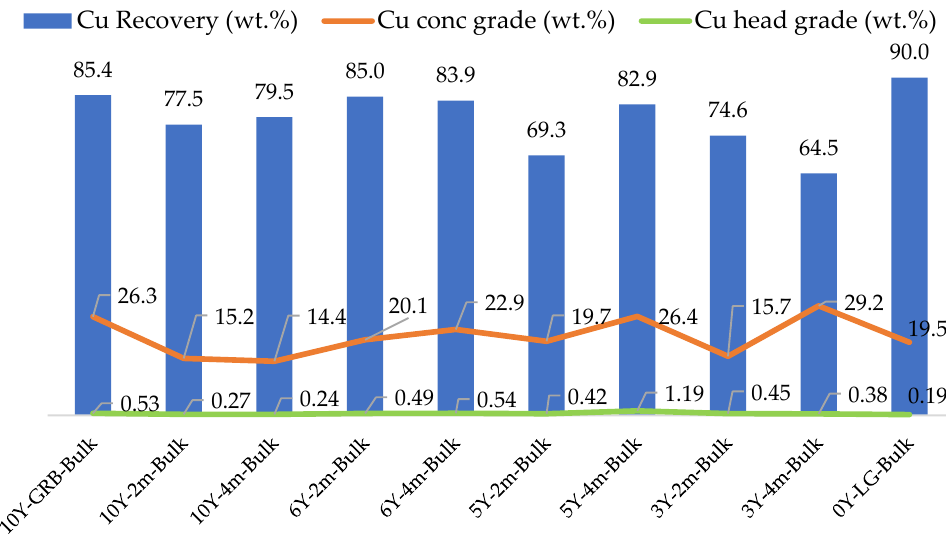
Figure 22. Results of the locked-cycle tests (Figure 3) performed in the bulk samples.